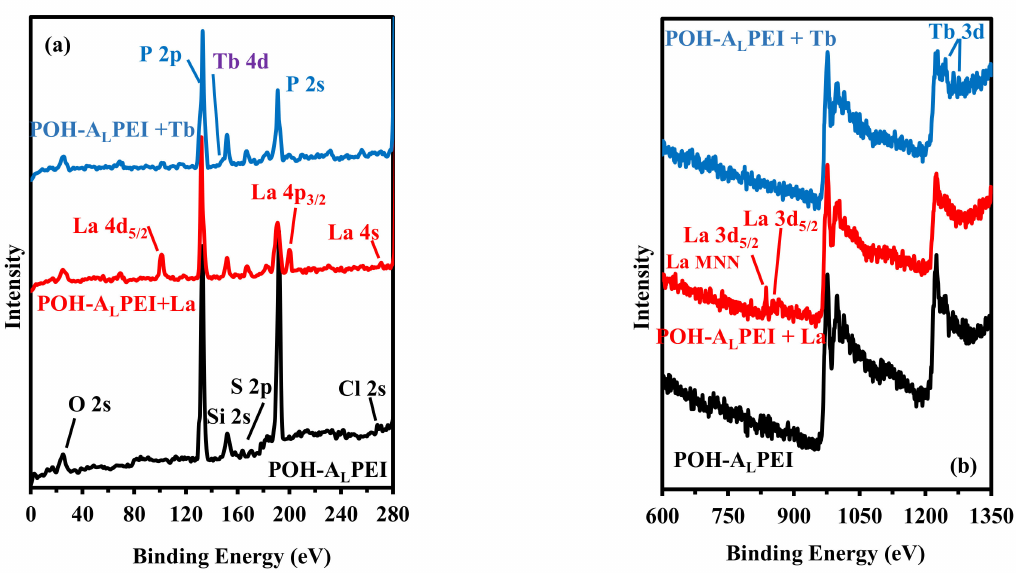
Figure 9. XPS survey spectra of A L PEI beads (before and after La(III) and Tb(III) sorption (focus on selected ranges of BEs ( a ): 0–280 eV; ( b ) 600–1350